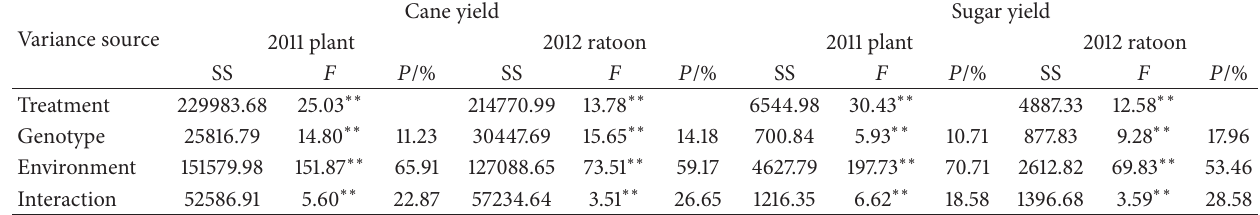
Table 2: Analysis of variance on cane and sugar yields of sugarcane cultivars.